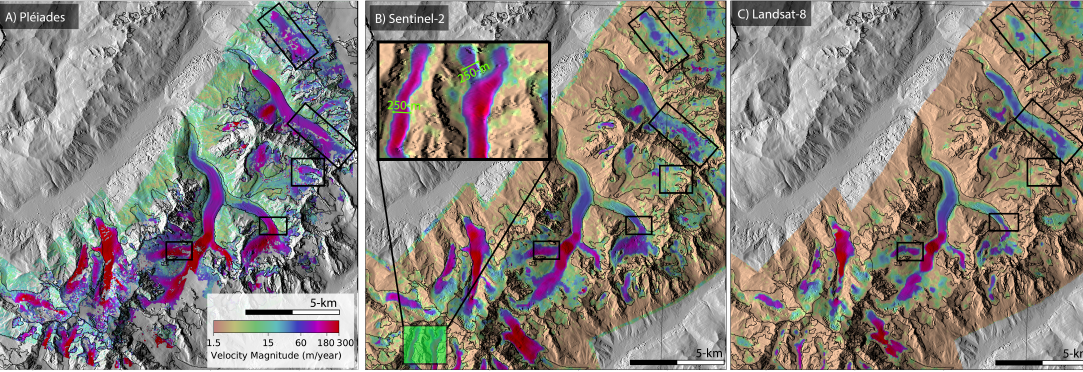
Figure 7. Comparison of glacier surface velocity fields obtained with ( A ) Pléiades; ( B ) Sentinel-2; and ( C ) Landsat 8. The Pléiades mosaic was obtained from a single 30-day pair of late summer 2018 whereas Sentinel-2 and Landsat 8 are 2017–2018 average mosaics of all 30-day and 32-day image pairs, respectively. Inset shows a zoom in the glacier surface velocity of two tributaries of the Miage Glacier called Dome and Mont-Blanc